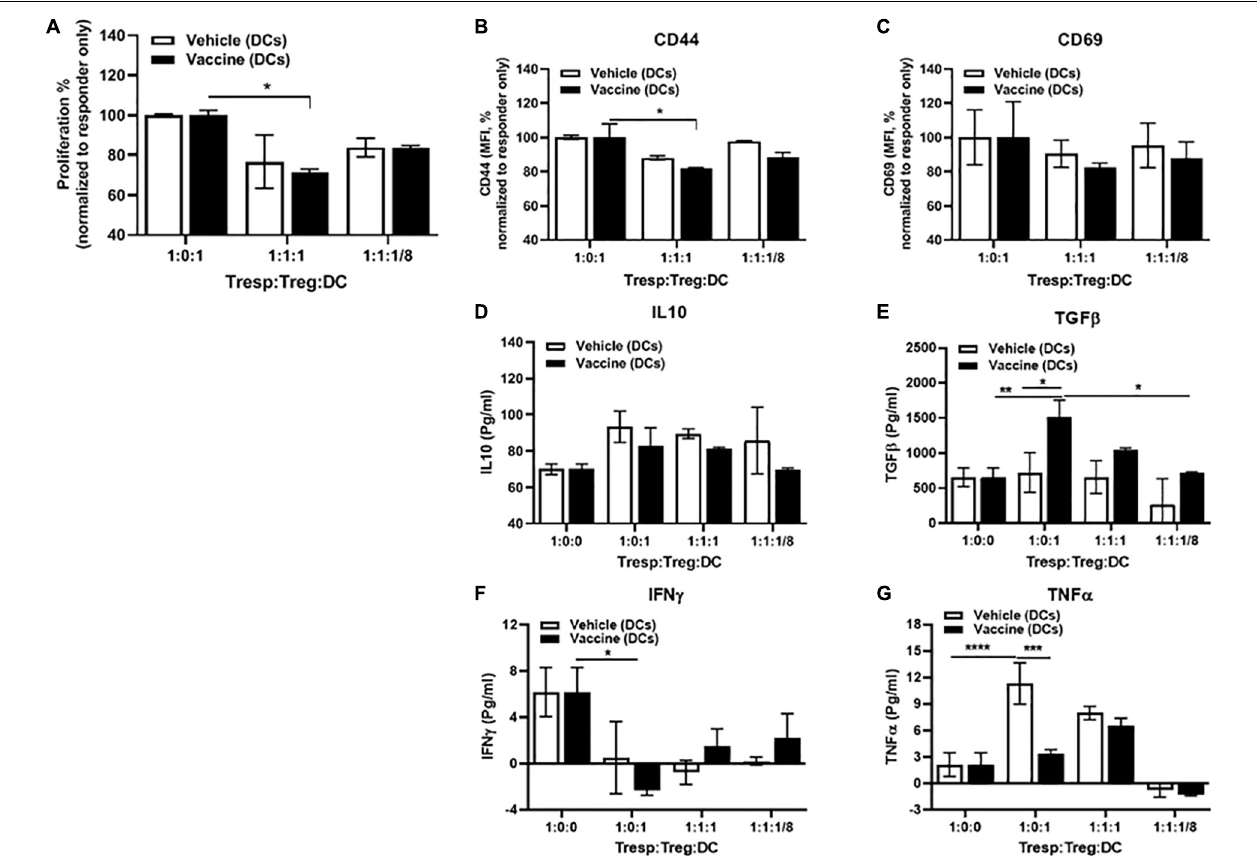
FIGURE 7 | DCs mediated in vitro Salmonella -based anti-inflammatory effects. Female 8-week-old NOD mice were treated with 2.5 µ g/mouse of anti-CD3 mAb via i.p. injection for 5 days followed by 2 doses of oral combined vaccines. Splenocytes were harvested from the indicated group at day 30 post-vaccination. CD4 + CD25 − Tresp cells isolated from splenocytes of B9-23 vaccinated mice were dye-labeled, co-cultured with CD4 + CD25 + Treg cells isolated from non-vaccinated mice, and DCs from vaccinated or non-vaccinated mice for 3 days with insulin peptide B9-23 (10 µ g/ml). (A) Proliferation of Tresp was measured by flow cytometry of dye dilution and shown as the percentage of Tresp normalized to Tresp only culture. (B) Activation of Tresps, shown as MFI of CD44 expression or (C) CD69 normalized to Tresp-only culture. ELISA for regulatory (D) IL-10, and (E) TGF β . ELISA for inflammatory (F) IFN γ , and (G) TNF α . The data shown are the average with SD from two independent experiments. Statistical analysis was performed using two-way ANOVA (* p < 0.05, ** p < 0.01, *** p < 0.001, **** p <